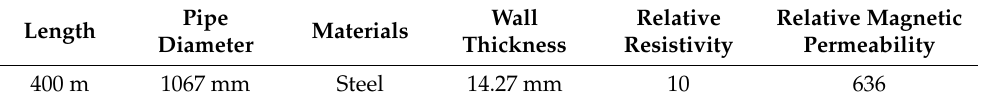
Table 2. Pipeline parameters.